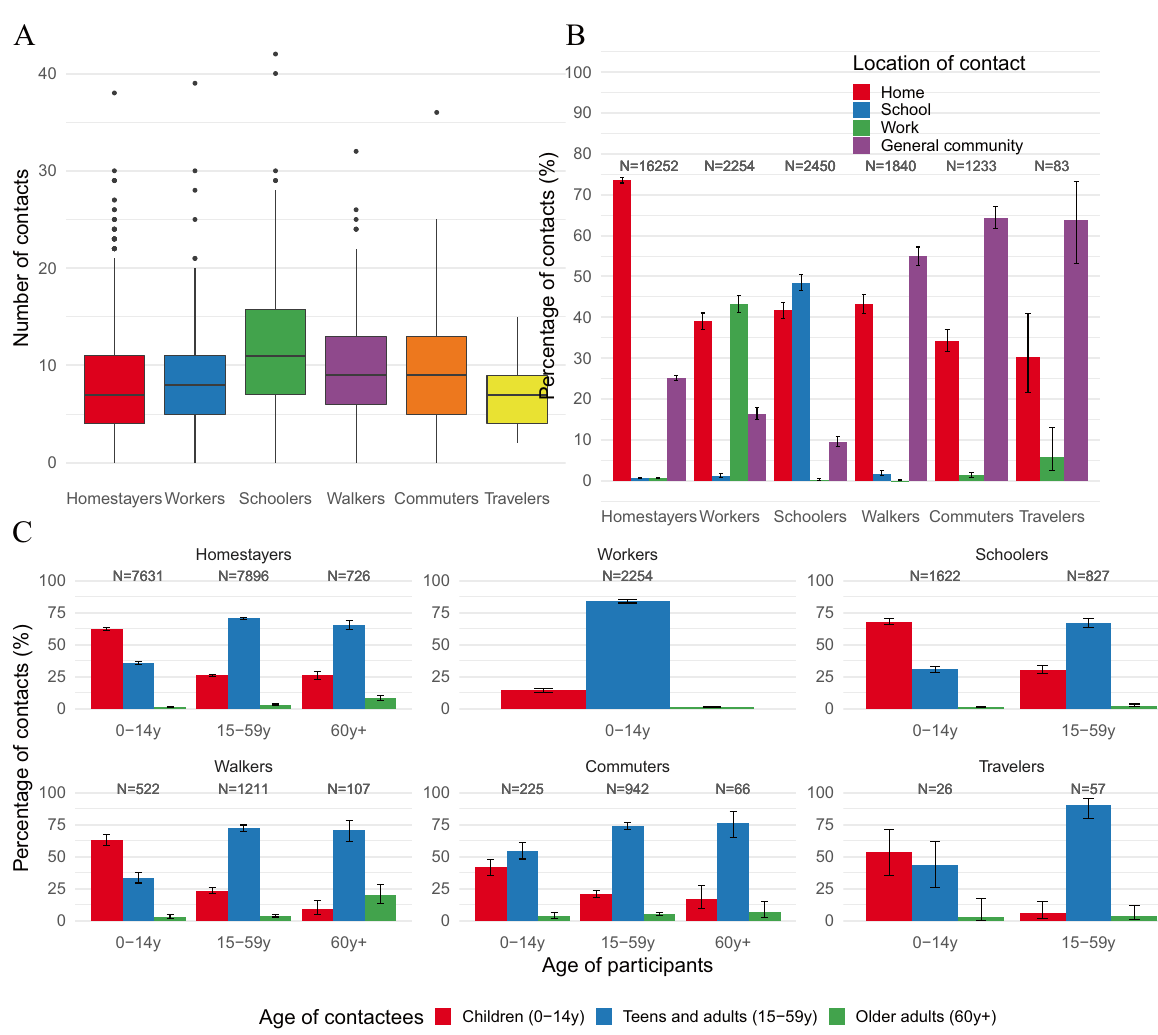
Figure 5. Distribution of daily social contacts by TU profile ( A ), percentage (with 95% CI) of daily social contacts by location of contact ( B ), and percentage (with 95% CI) of daily social contacts by TU profile group and age of participants with children (0–14 years), teens and adults (15–59 years) and older adults (60+ years) ( C ). For each bar, the respective denominator (N) is reported. All CIs are computed as Wilson CIs for a binomial proportion 42